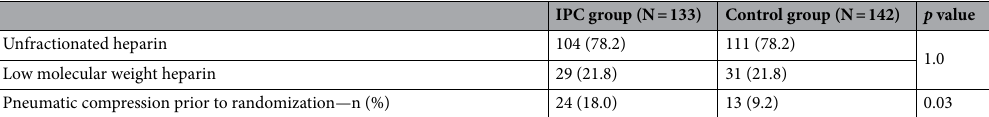
Table 1. Baseline characteristics of patients with heart failure who were randomized to intermittent pneumatic compression with pharmacologic thromboprophylaxis (IPC group) or pharmacologic thromboprophylaxis alone (control group). APACHE Acute physiology and chronic health evaluation, ICU Intensive care unit, INR International normalized ratio, IPC Intermittent pneumatic compression, PTT Partial thromboplastin time, Q1